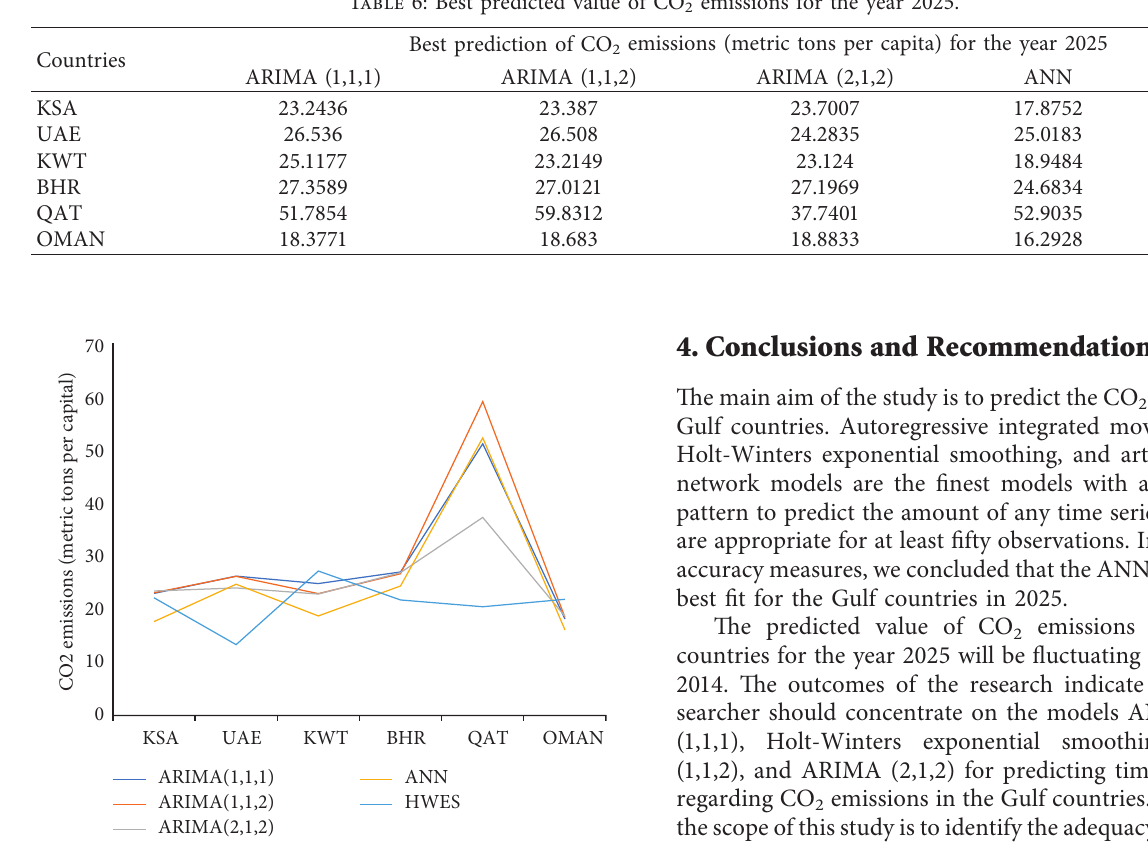
Figure 7: Best predicted values of CO